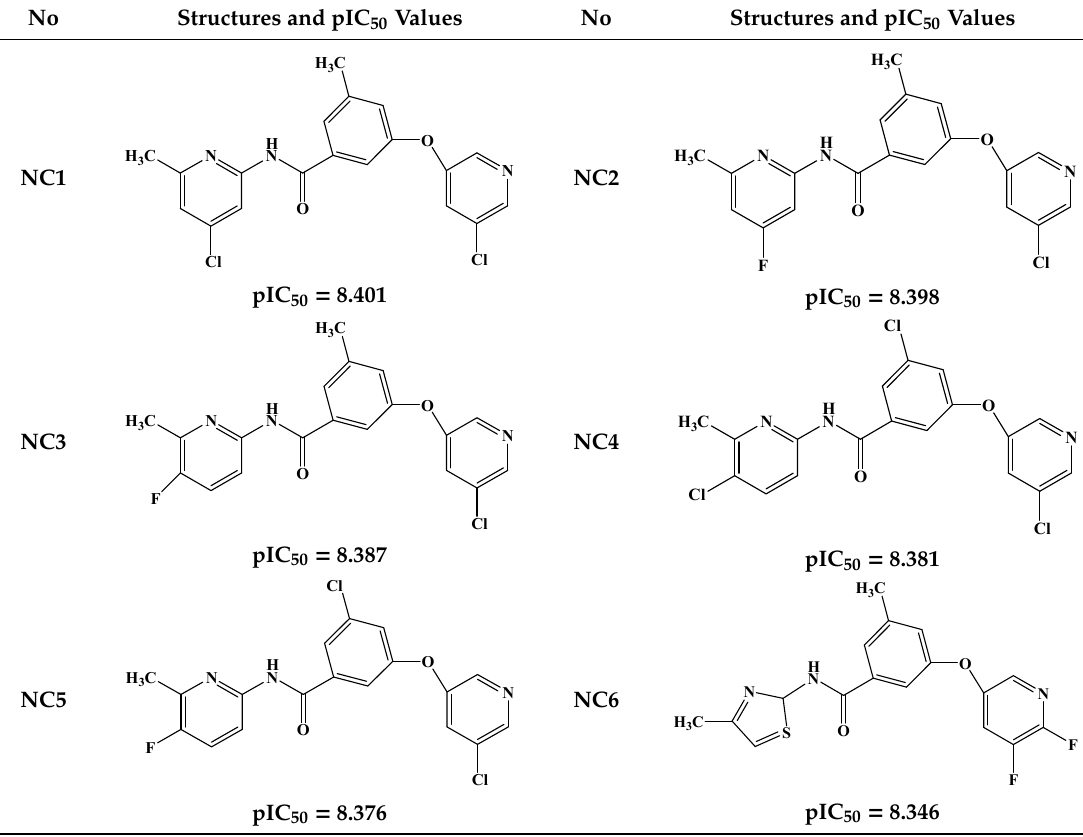
Figure 12. Binding modes of NAMs with mGluR5. ( A ) The “linear” docking modes of compound 6bj. ( B ) The “arc” docking modes of compound Dipalglurant.